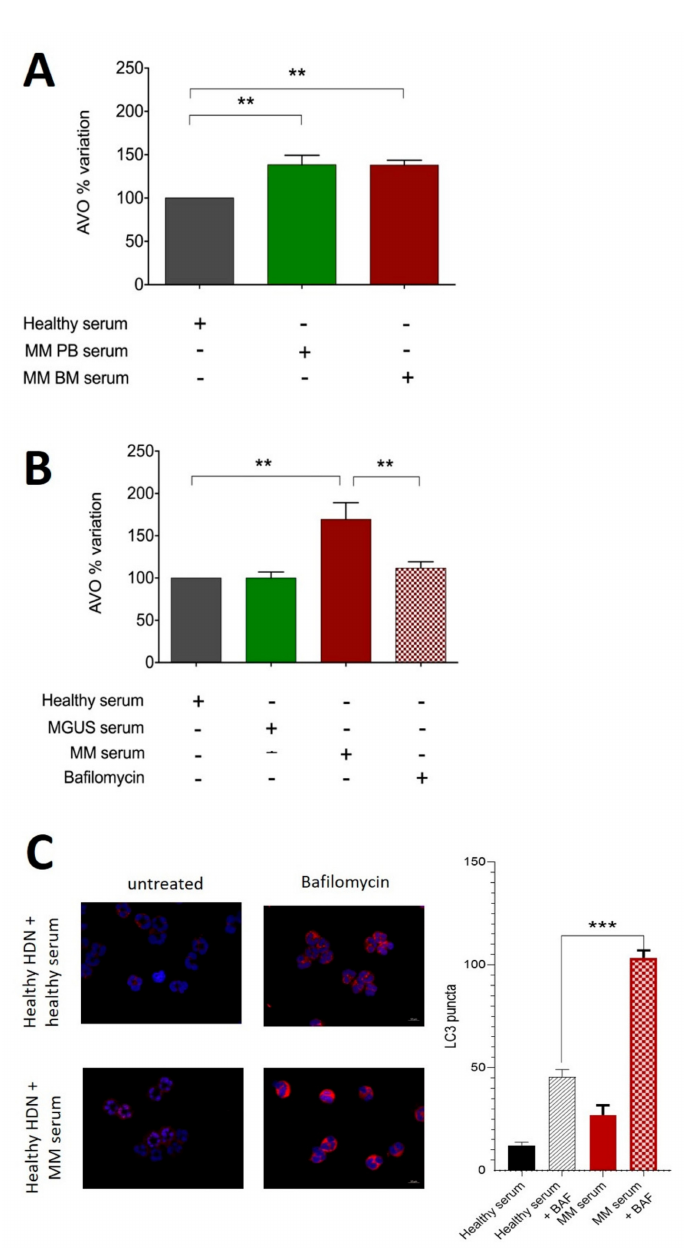
Figure 4. Soluble factors in peripheral blood and bone marrow of MM patients can trigger autophagy in high-density neutrophils. ( A ) HDNs were isolated from healthy donors as described in the Methods section and cultured with sera obtained from MM peripheral blood (PB) and bone marrow (BM) or allogeneic healthy donor for 3 h before being stained with acridine orange to detect the formation of acidic vesicular organelles (AVOs) quantified by flow cytometry. Bars represent mean and standard deviation of 5 independent experiments based on 3 different individual donors and 3 individual MM patients. The experiment in A was repeated using PB sera obtained from MGUS (green bar) or MM (red bar) patients in the presence of the autophagy inhibitor bafilomycin. ( C ) Healthy donor-derived HDNs described in A – B were seeded on poly-L-lysine-coated slides, fixed with 3.7% formaldehyde for 10 min, and permeabilized with PBS 0.1% Triton X100 10 min at RT. Cells were stained with monoclonal Ab against LC3B (Fk2, Enzo Biochem Inc., Farmingdale, New York, NY, USA; 1:200 1h RT, in red) and DAPI. Coverslips were observed using a Zeiss Axio Imager Z1 Microscope with Apotome 2 system (Zeiss, Milan, Italy) equipped with an AxioCam camera (Zeiss, Jena, Germany). The numerical aperture was 1.35 (40 × lens), and images of HDNs were deconvoluted with SoftWorx 3.5.0 (Applied Precision, Bratislava, Slovakia). Fluorescence intensity was quantified in an automated fashion with IN Cell Investigator software (GE Healthcare, Piscataway, NJ, USA). *** p < 0.0001; ** p < 0.001; (Student’s t